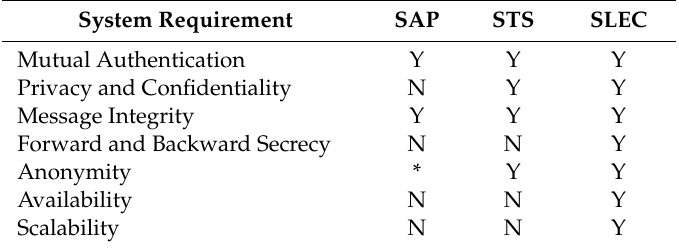
Table 2. Comparison of System